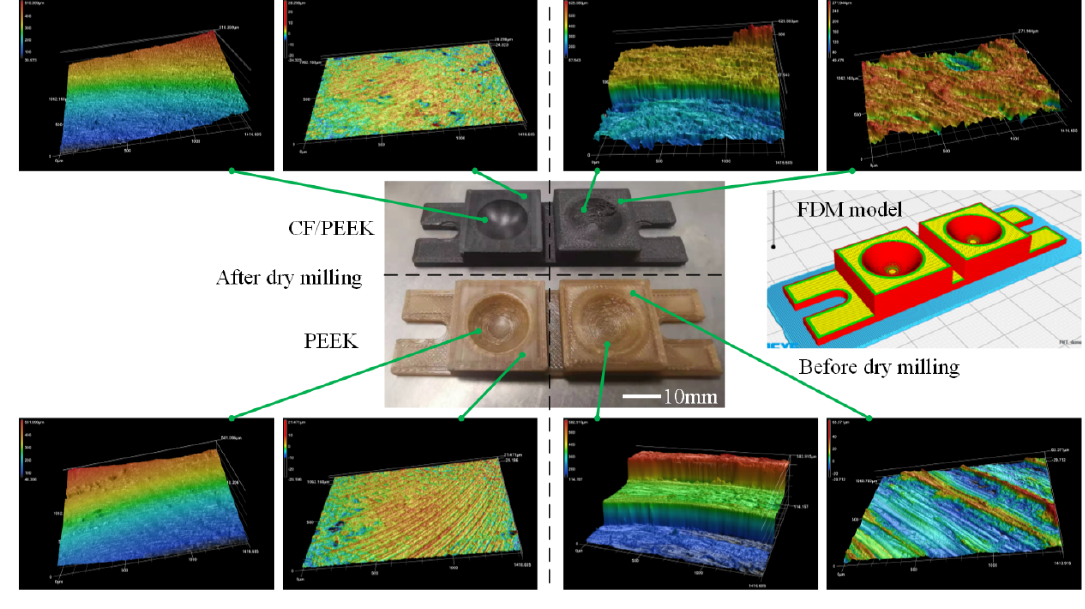
Figure 19. Comparison of additive–subtractive manufacturing of PEEK and CF/PEEK parts: before dry milling ( right ) and after dry milling ( left ). Table 4. Parameters for dry milling of the plane and curve surfaces.